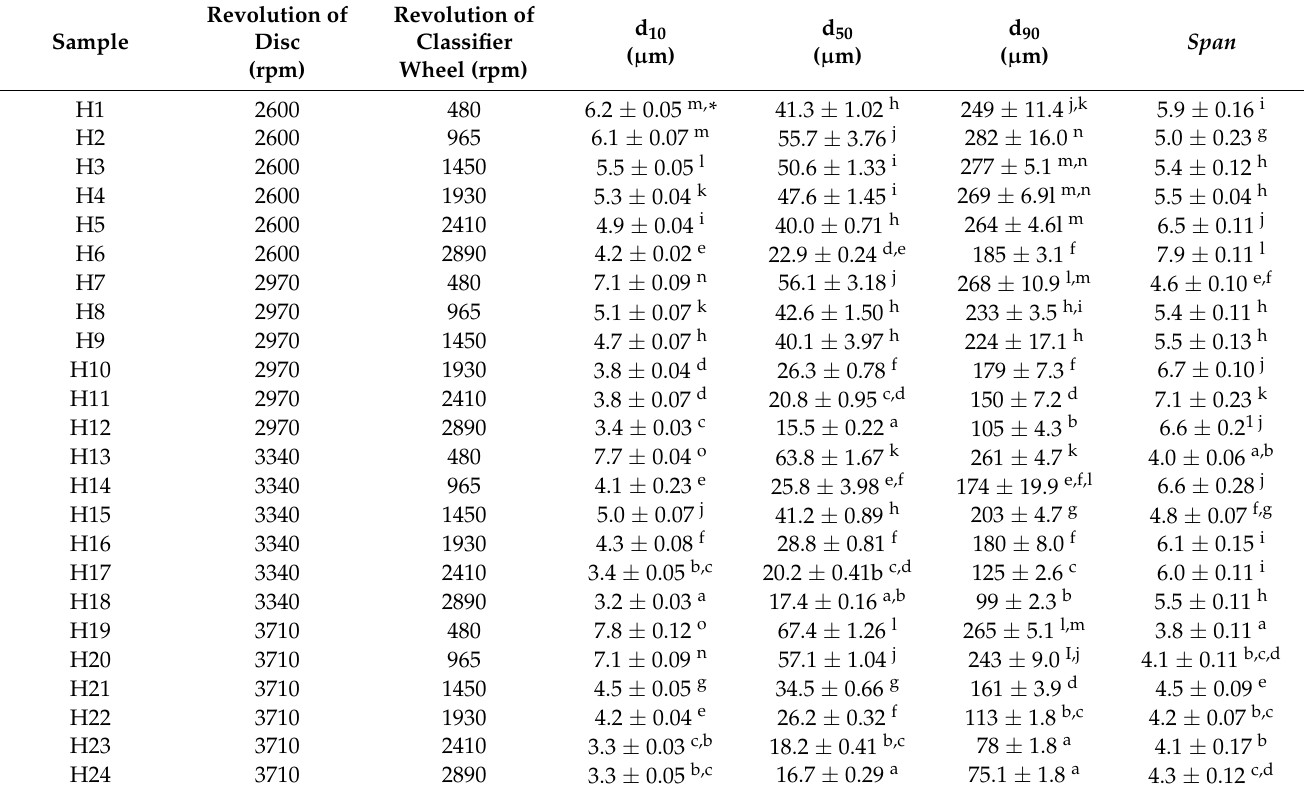
Figure 1. Example curves of the PSD of OH (sample H18, eight repetitions). Table 2. Parameters that describe the particle size distribution of micronized